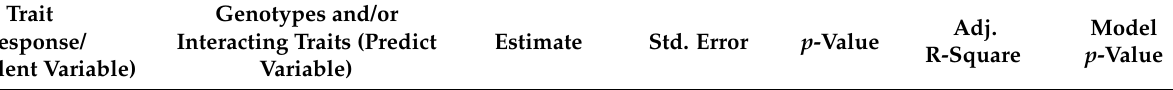
Table 4. Linear regression model illustrating the link between the study variant and interaction of HDL with PBF, ApoA1A, ApoC1, and ApoB48. Results are shown for combined minor allele homozygous and heterozygous genotypes (AG and GG) regressed against the major AA genotype @